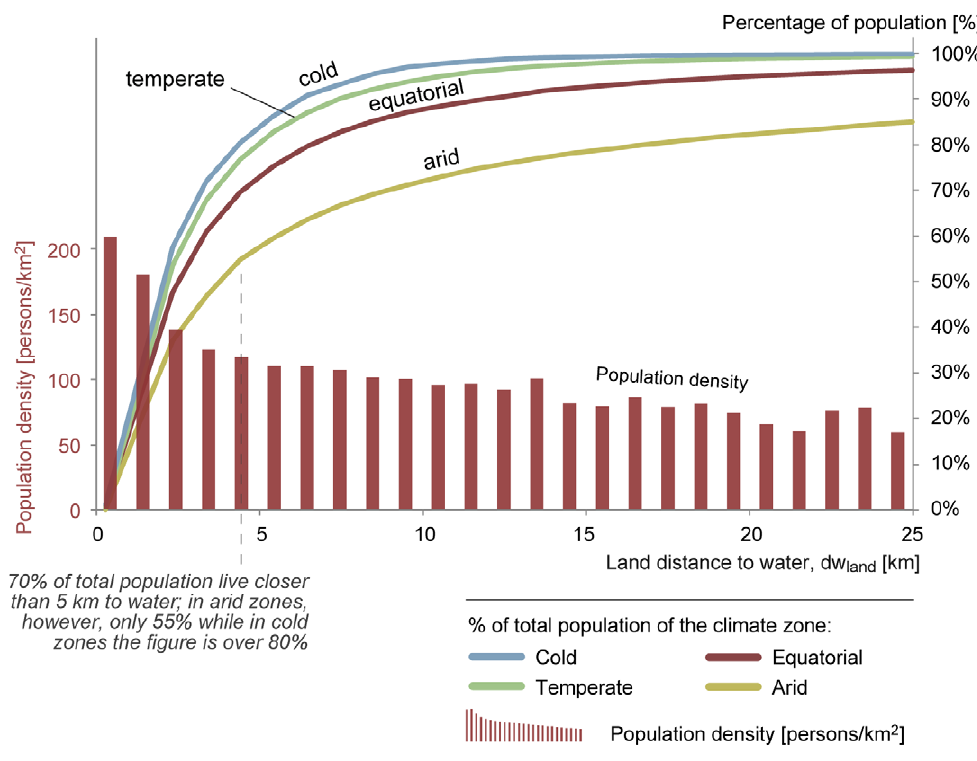
Figure 3. Population density vs. land distance to water ( dw land ) (bars) and the percentage of total population vs. distance to water (lines, differentiated between climate zones).